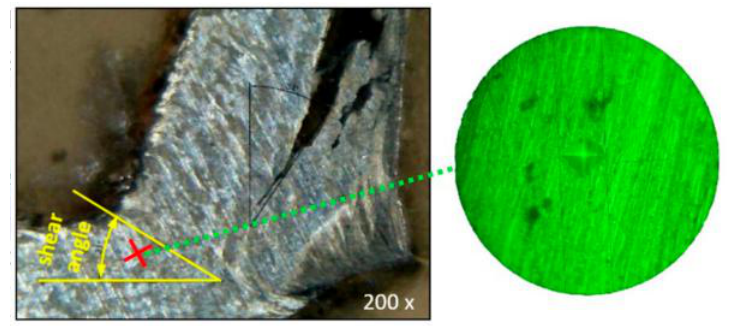
Figure 11. Diamond body imprint with magnification 600 × . Table 9. Experimentally obtained values of microhardness HV measured in the area of the shear angle at